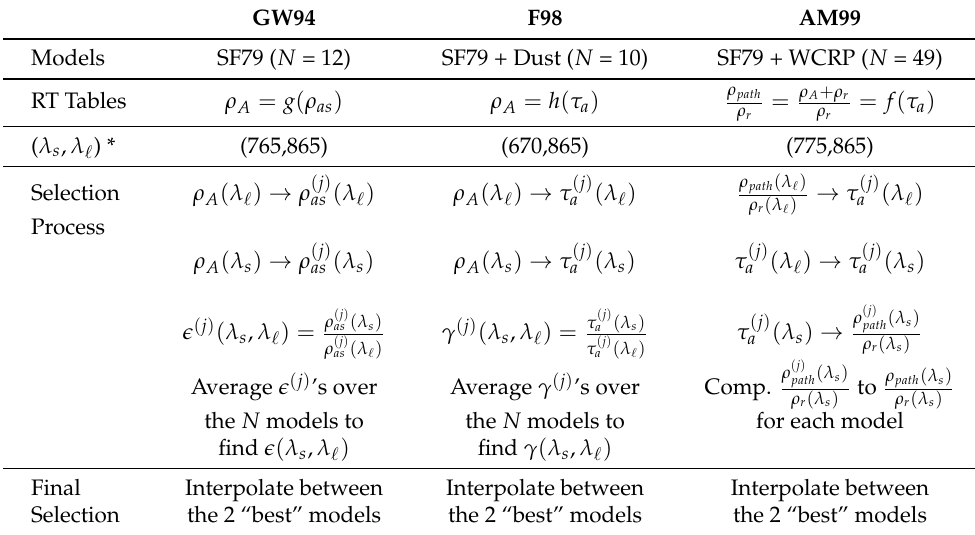
Table 2. Comparison of multiple scattering algorithms for SeaWiFS, OCTS, and MERIS. The super- script “ j ” refers to the j th aerosol